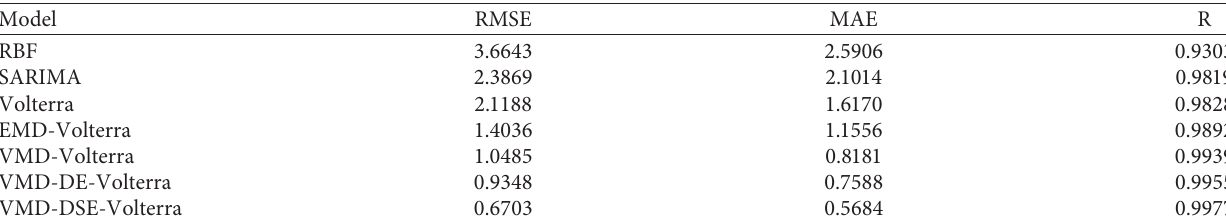
Figure 11: Bar chart of model error index. M1: RBF, M2: SARIMA, M3: Volterra, M4: EMD-Volterra, M5: VMD-Volterra, M6: VMD-DE- Volterra, and M7: VMD-DSE-Volterra. Table 3: Error analysis of each prediction model in Xianyang area.